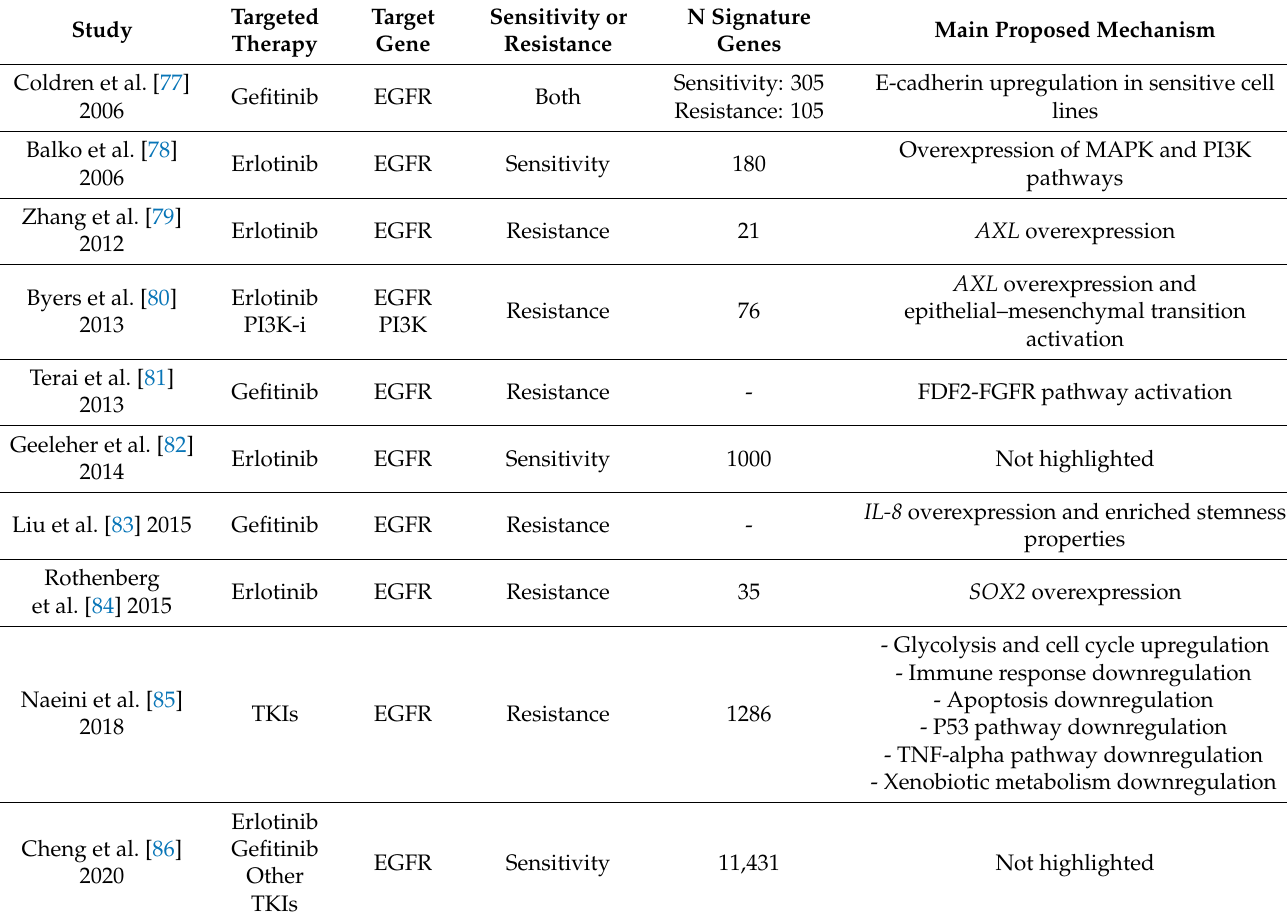
Table 3. EGFR targeted therapy resistance/sensitivity transcriptional signatures and proposed molecular